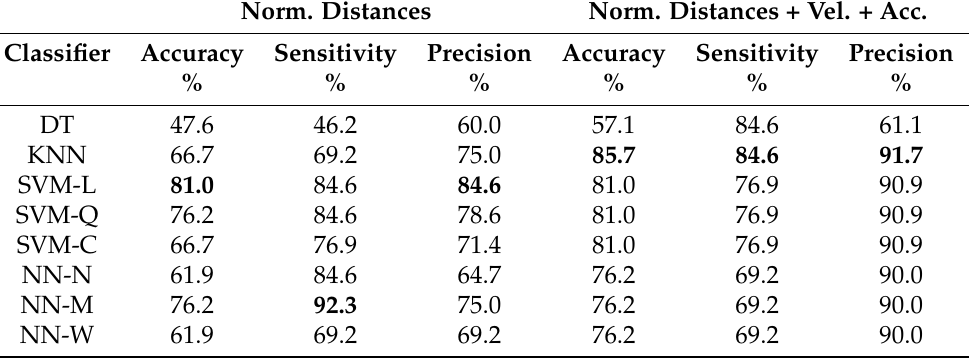
Table 2. Classification results when normalized distances ( D d , i ) and normalized distances plus velocity ( D (cid:48) ) and acceleration ( D (cid:48)(cid:48) ) were used as feature vectors. The maximum percentages are d , i d , i highlighted in bold. Norm. Distances Norm. Distances + Vel. +